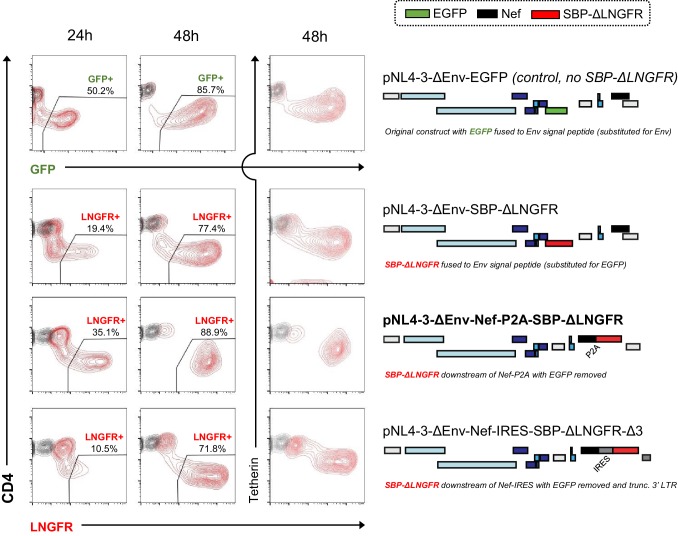
Time course evaluation of selected SBP-ΔLNGFR-expressing HIV viruses.Expression of GFP (pNL4-3-ΔEnv-EGFP only) or cell surface SBP-∆LNGFR (all other constructs) and CD4 or tetherin in CEM-T4s 24 or 48 hr post-infection with HIV-AFMACS. Cells were stained with anti-LNGFR and anti-CD4 or anti-tetherin antibodies at the indicated time points and analysed by flow cytometry (red, infected cells; grey, mock infected cells). Schematics indicate the location/setting of SBP-ΔLNGFR within each provirus, with ORFs and non-coding features coloured as in Figure 1B (but with Nef in black and EGFP in green). For simplicity, reading frames are drawn to match the HXB2 HIV-1 reference genome. The final HIV-AFMACS virus is highlighted (pNL4-3-ΔEnv-Nef-P2A-SBP-ΔLNGFR, bold text). pNL4-3-ΔEnv-EGFP was included as a control.